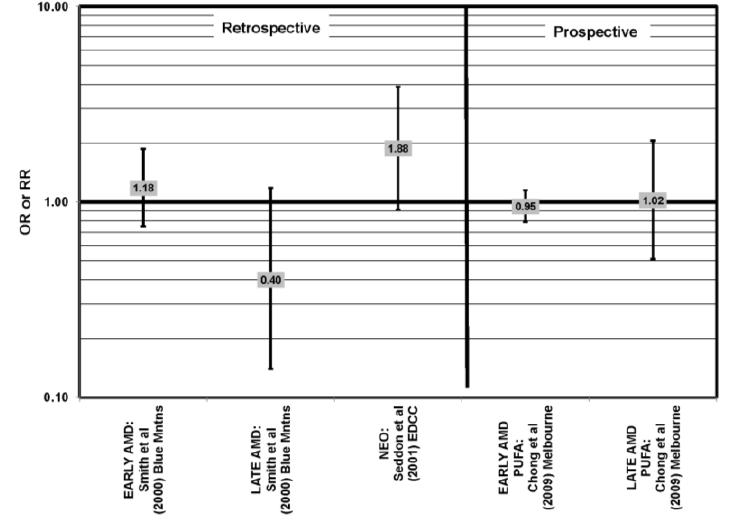
Figure 16. AMD odds or risk ratio; high vs. low intake of polyunsaturated fatty acids: retrospective and cross-sectional studies,